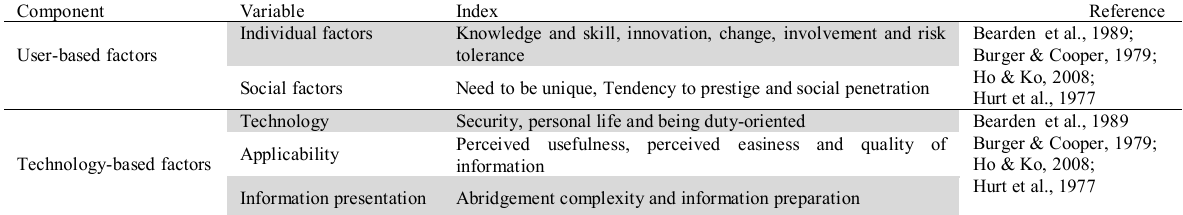
Exogenous constructs and their measuring indices